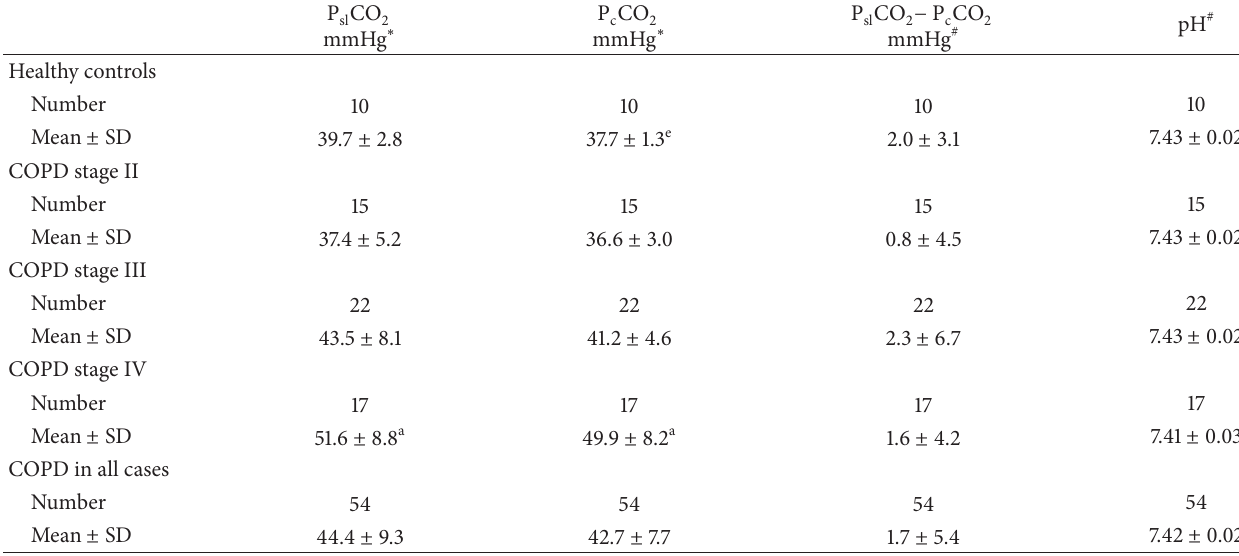
, arterialized capillary blood PCO 2